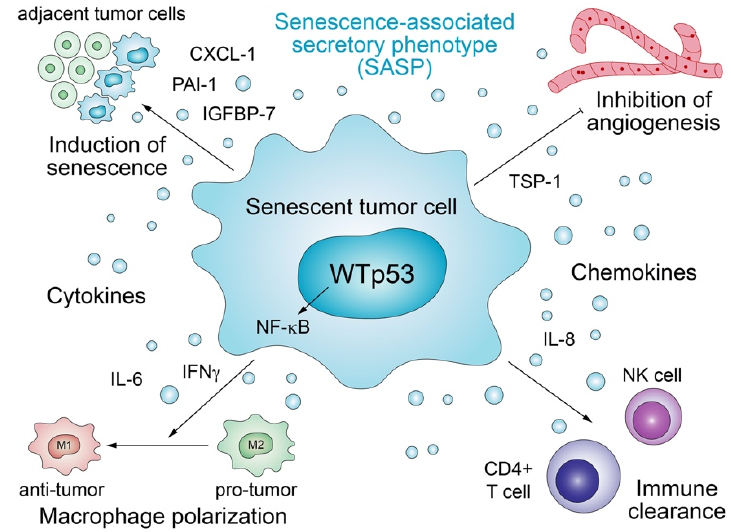
Figure 2. Abrogation of the wild ‐ type p53 secretome by TP53 mutations. The senescence ‐ associated secretory phenotype (SASP) driven by wild ‐ type p53 induces senescence in neighboring tumor cells, inhibits angiogenesis, polarizes macrophages to the anti ‐ tumor M1 phenotype, and activates NK and T cells to trigger immune